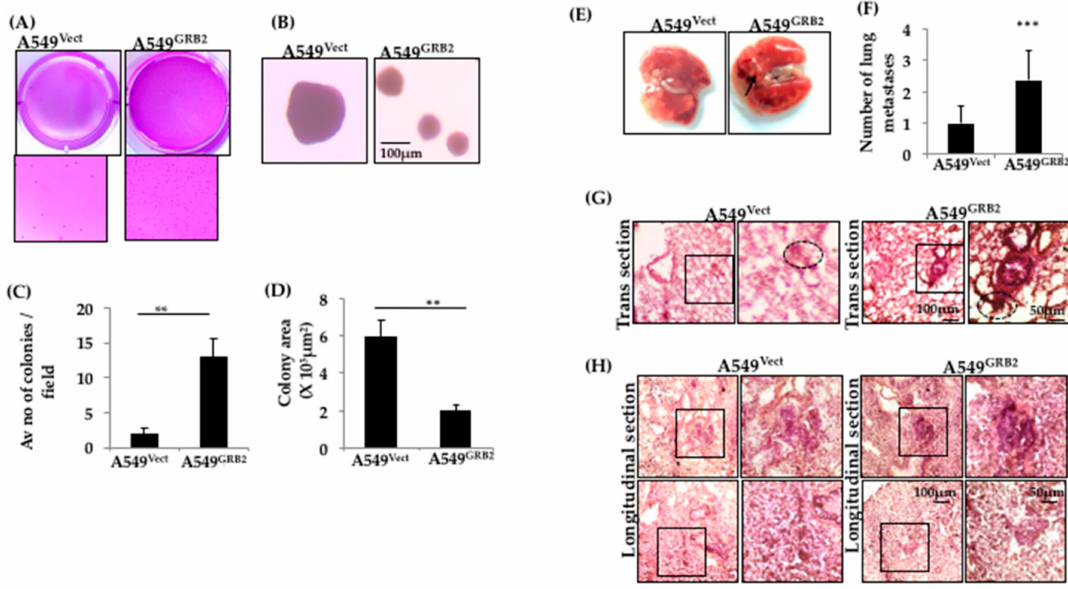
Figure 6. Overexpression of GRB2 enhanced anchorage-independent growth of A549 cells and in vivo lung metastasis. ( A ) A549 Vect and A549 GRB2 cells were subjected to a soft agar colony formation assay, where A549 cells were allowed to form colonies for 15 days, stained with 0.05% crystal violet, and imaged. Digital images of the wells are shown; ( B ) Images of the colonies were captured using a 4 × objective lens of a phase contrast microscope and used for counting the number colonies and measuring area of colonies; ( C ) Colonies in ten random fields per sample were counted to quantify the average number of colonies/microscopic field. Three independent sets of experiments were carried out to calculate significance; ( D ) Ten colonies per sample were used to quantify the average colony area using Image J software. Three independent sets of experiments were carried out to calculate significance; ( E ) Digital images of the lungs from mice ( n = 5) injected with A549 Vect and A549 GRB2 cells, respectively, were taken. Representative images are shown here; ( F ) The number of lung metastases in individual mice were counted under a microscope. 5 mice per sample were considered to calculate significance (*** p < 0.001); ( G ) Images of lung sections were taken from lung cryosections of the mice injected with A549 Vect and A549 GRB2 cells using a 4 × objective lens of a phase contrast microscope. Lung metastases are circled. Representative images are shown here; ( H ) Images of lung metastases for the longitudinal and transverse cryosections of mice injected with A549 Vect and A549 GRB2 cells were taken using a 4 × objective lens. Metastases are highlighted for each sample. Representative images are shown